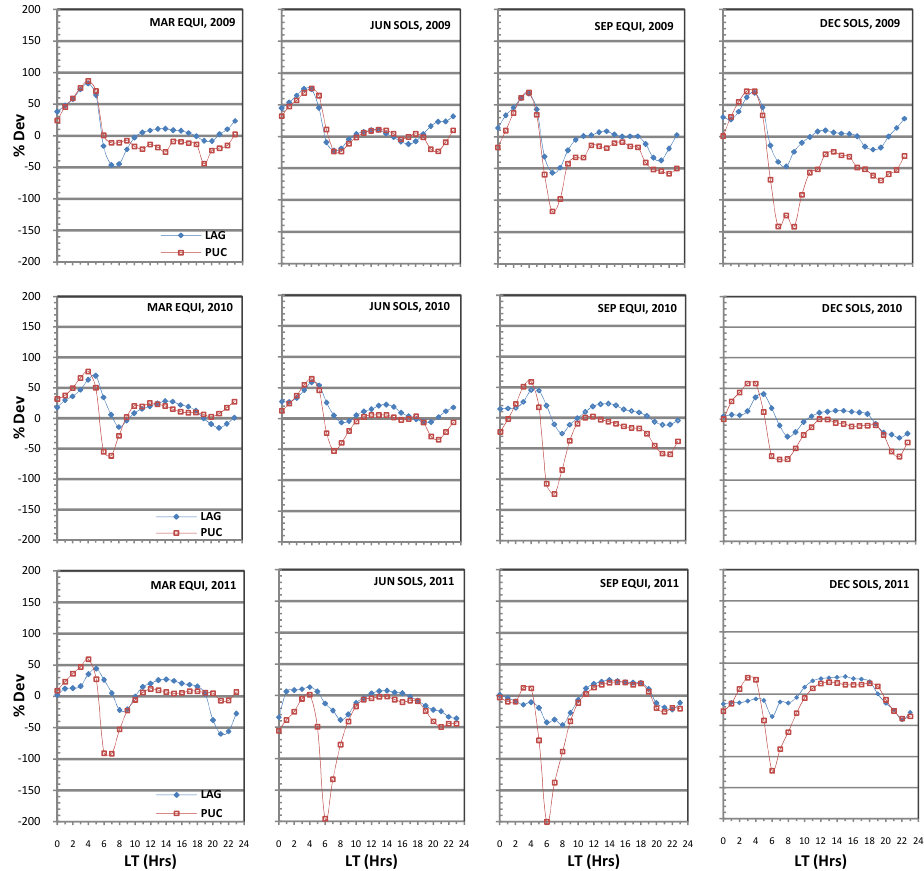
Fig. 7. Percentage variations of the IRI-2007-derived TEC from the GPS observed VTEC values for all seasons at the Lagos and Pucallpa stations during 2009, 2010, and 2011 respectively.